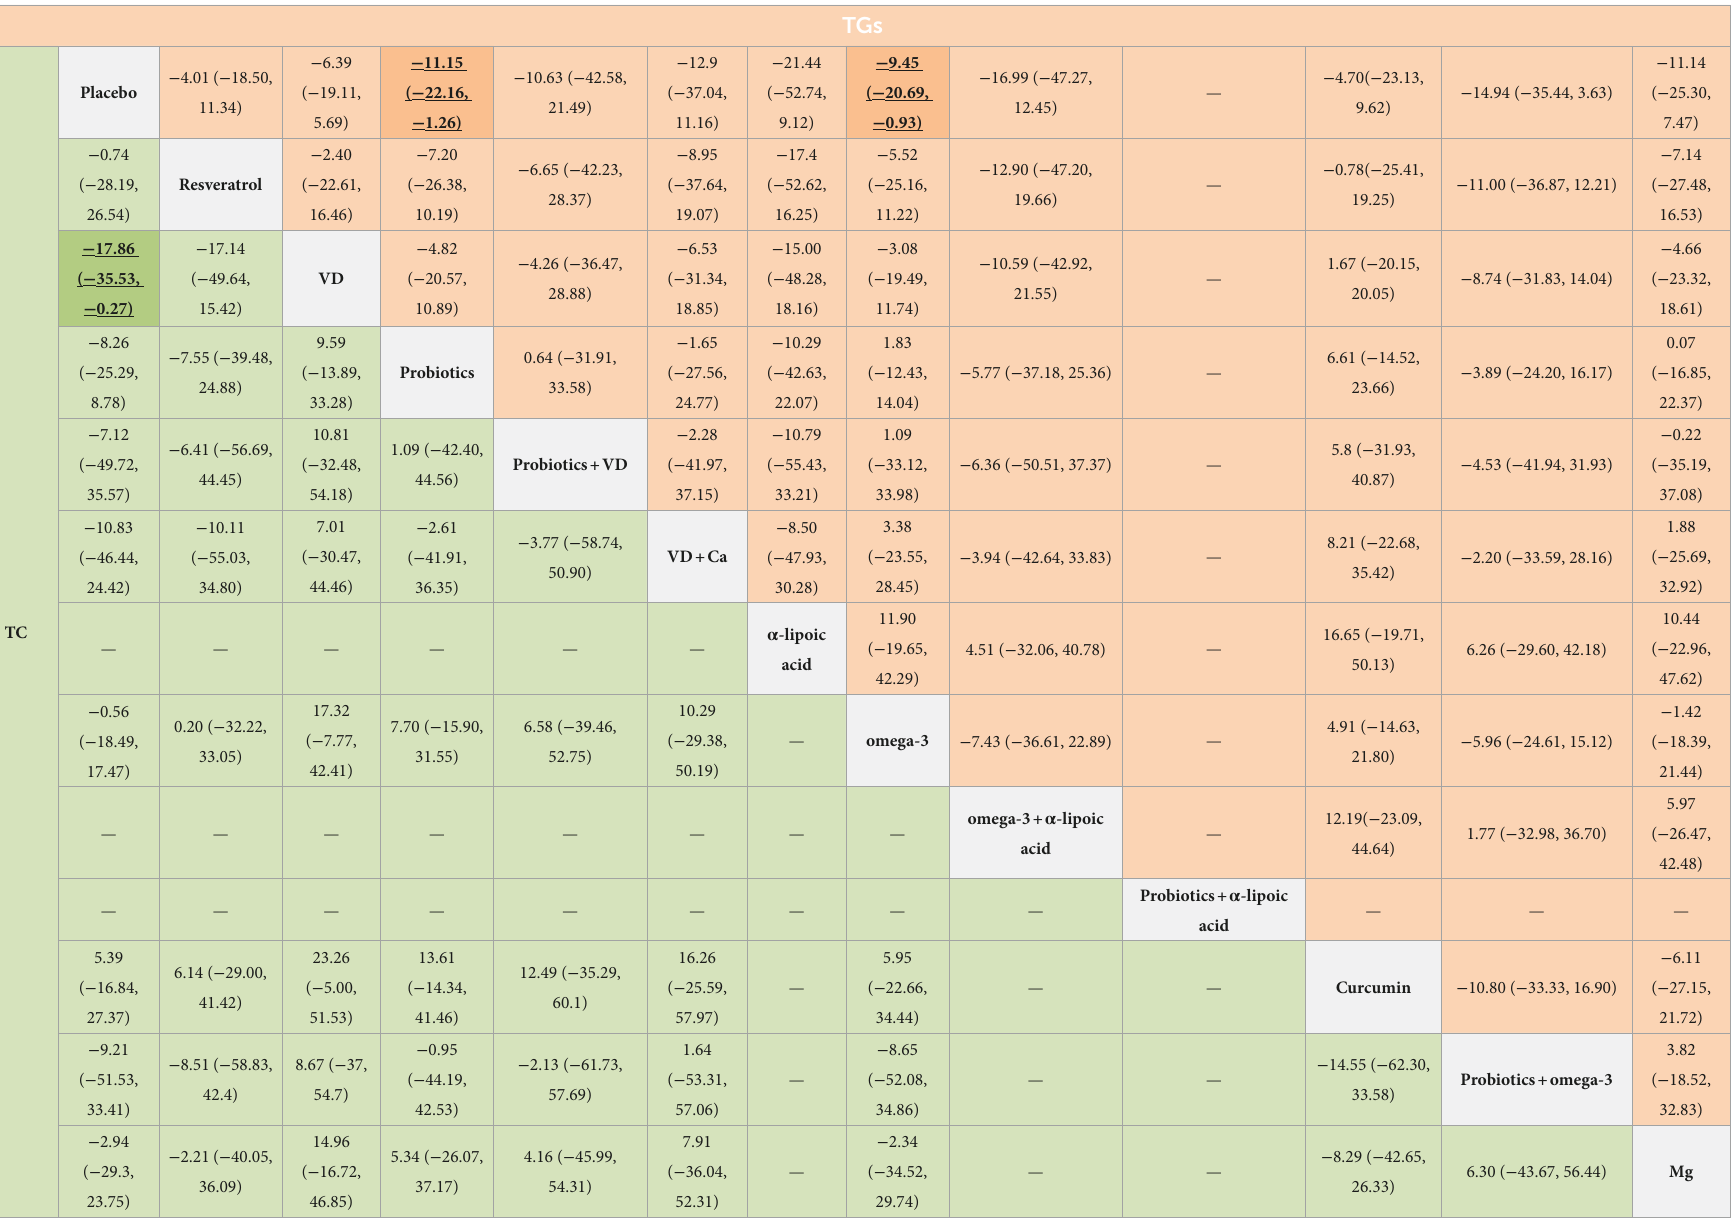
TABLE 4 Results of the network meta-analysis of TC (lower-left quadrant) and TGs (upper-right